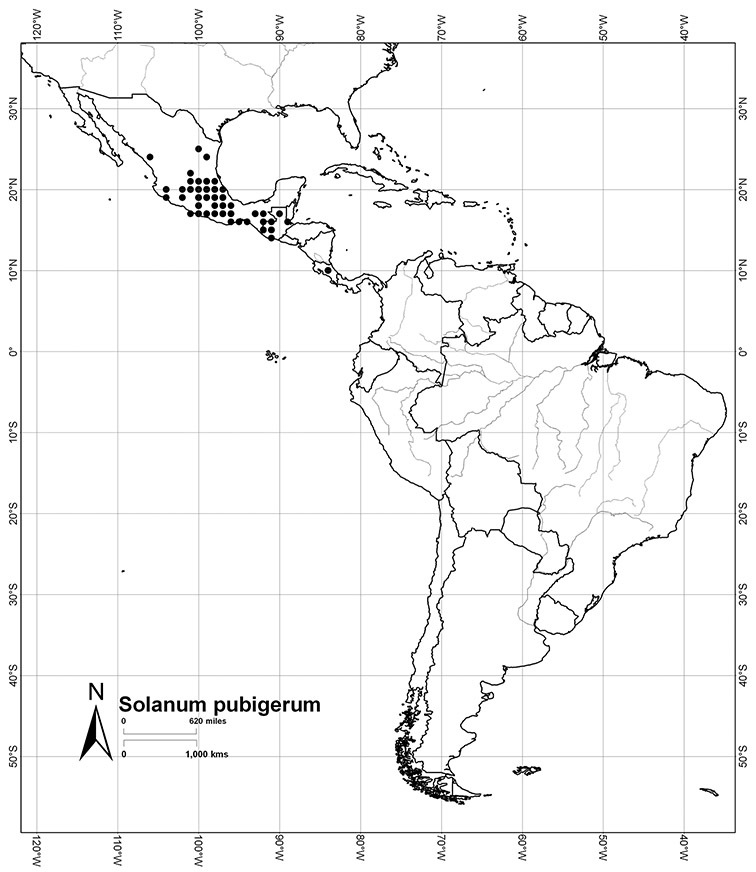
Distribution of Solanumpubigerum Dunal.